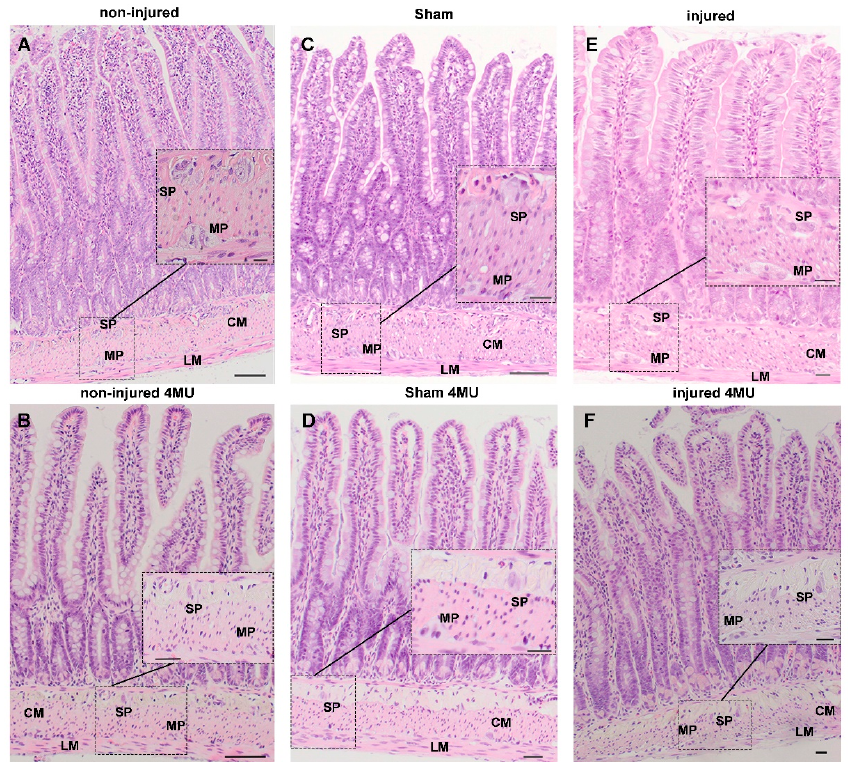
Figure 1. 4-MU treatment prevents morphological changes in the rat small intestine wall after IRI. ( A – F ) Smooth muscle cells in the circular (CM) and longitudinal (LM) layers, submucosal (SP) and myenteric plexus (MP) of non-injured ( A ), non-injured 4-MU-treated ( B ), sham-operated ( C ), sham 4-MU-treated ( D ), injured ( E ) and injured 4-MU-treated ( F ) rat small intestine (Hematoxylin & Eosin, scale bar = 50 µm).